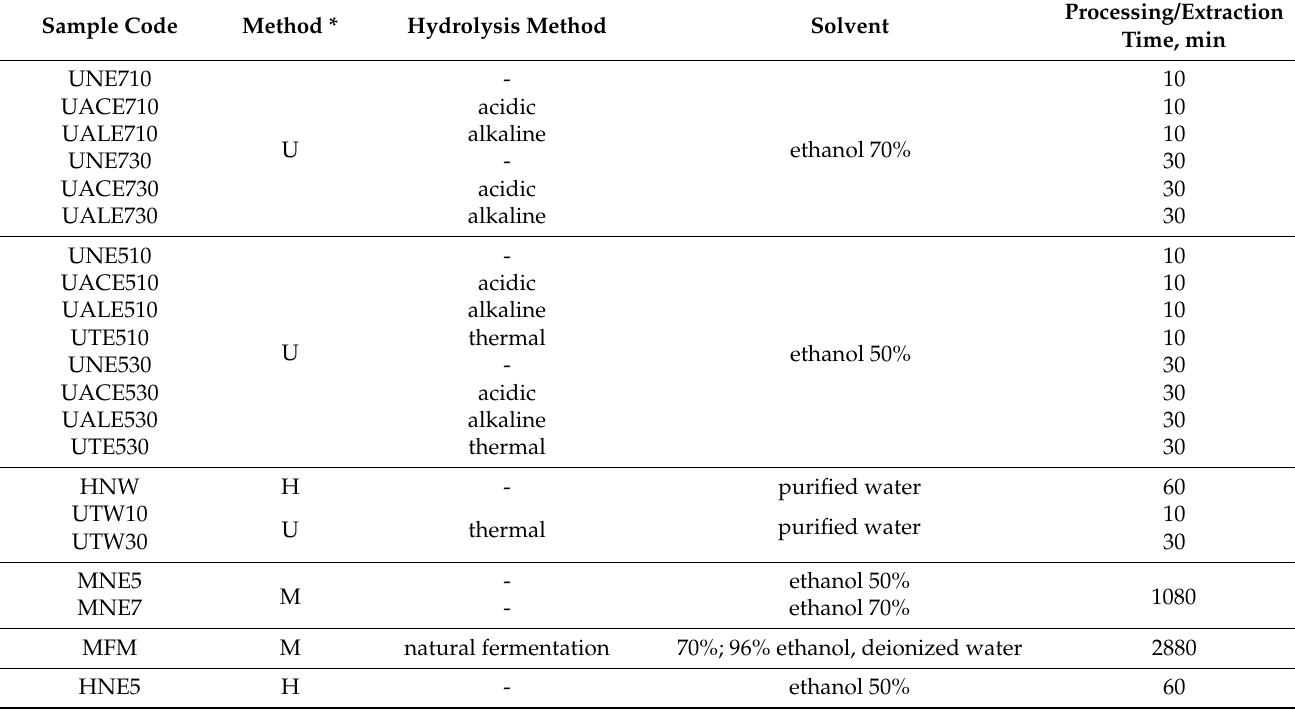
Table 1. Extraction conditions used for the